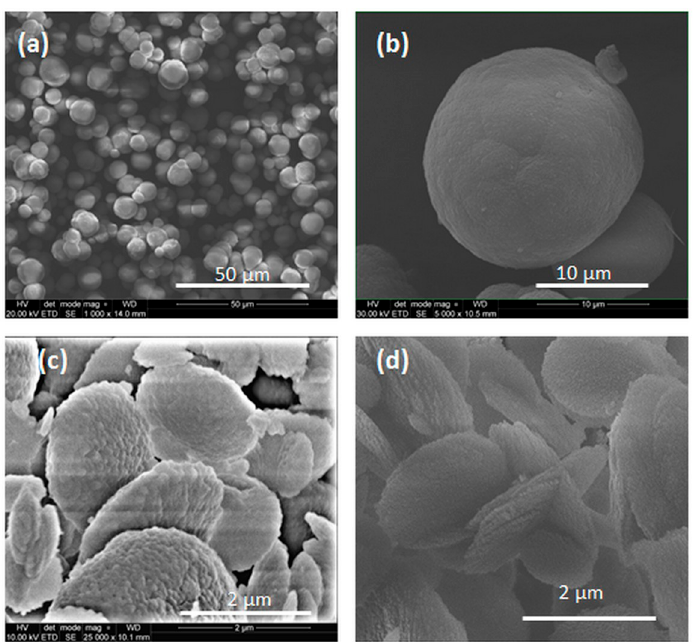
Figure 2. Vaterite particles: ( a ) and ( b ) typical spherical particles; ( c ) spherical and lens-like particles; ( d ) deformed lens-like and crossed lens-like particles.